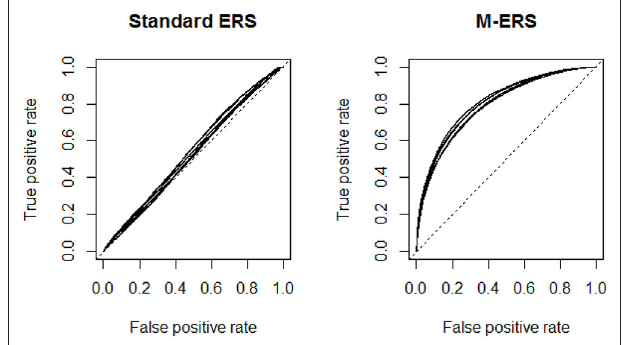
FIGURE 1 | Receiver operating characteristic (ROC) curves for a standard ERS and M-ERS. Note . Each panel includes six ROC curves representing a total of 6 simulation conditions (2 patterns of dimensionality × 3 correlations among ability parameters).